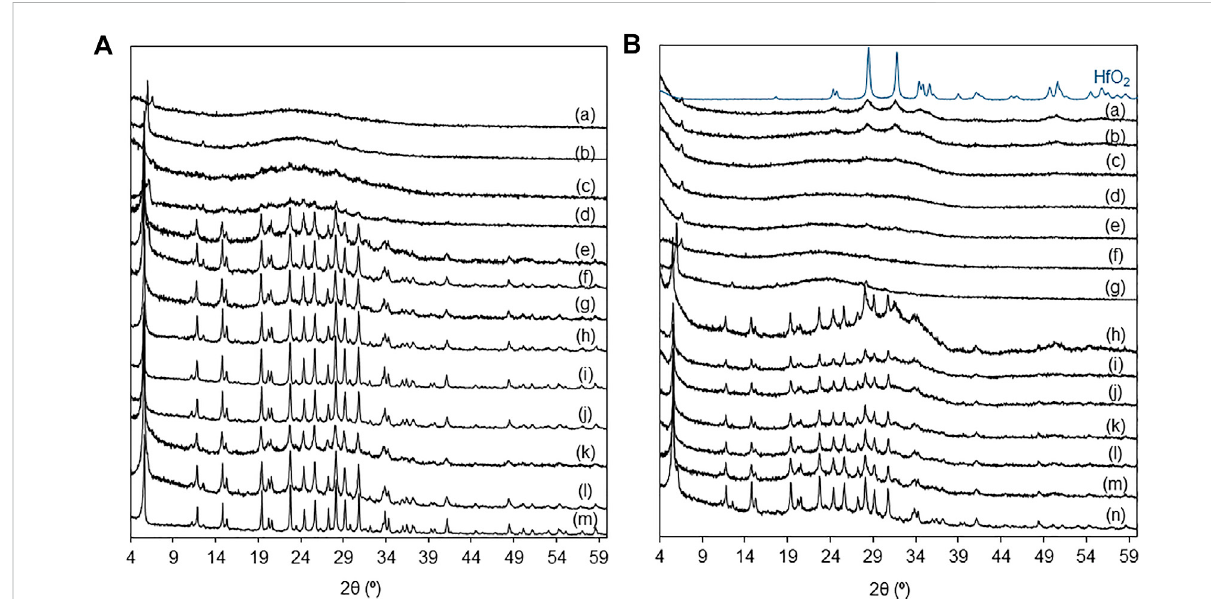
FIGURE 2 (A) PXRDpatternsof(a)D-HL(x)withx=0.28(b),0.20(d),0.15(f),0.10(h);0.28Hf-D-HL(x)withx=0.28(a),0.20(c),0.15(e),0.10(g);D-KL(i);KL (oxac)(j);0.28Hf-HL(k);HL(l);KL(m). (B) PXRDpatternsofyHf-D-HL(0.28)withy=1.68(a),1.40(b),1.12(c),0.84(d),0.56(e),0.28(f);D-HL(0.28)(g); yHf-D-HL(0.15) with y = 1.68 (h), 1.40 (i), 1.12 (j), 0.84 (k), 0.56 (l), 0.28 (m); D-HL(0.15) (n); bulk HfO 2